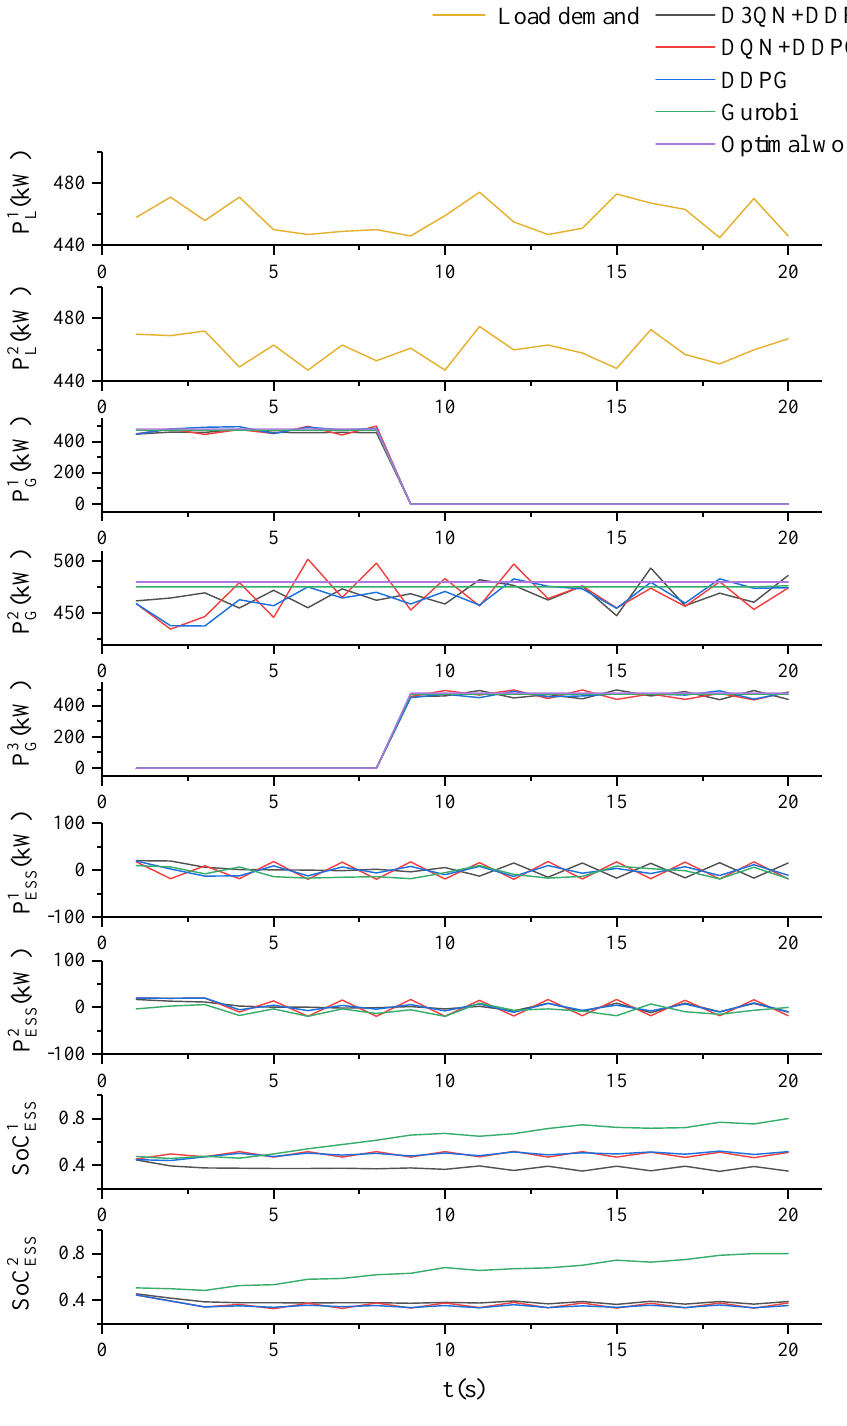
Figure 8. Condition 2 (main generator 1